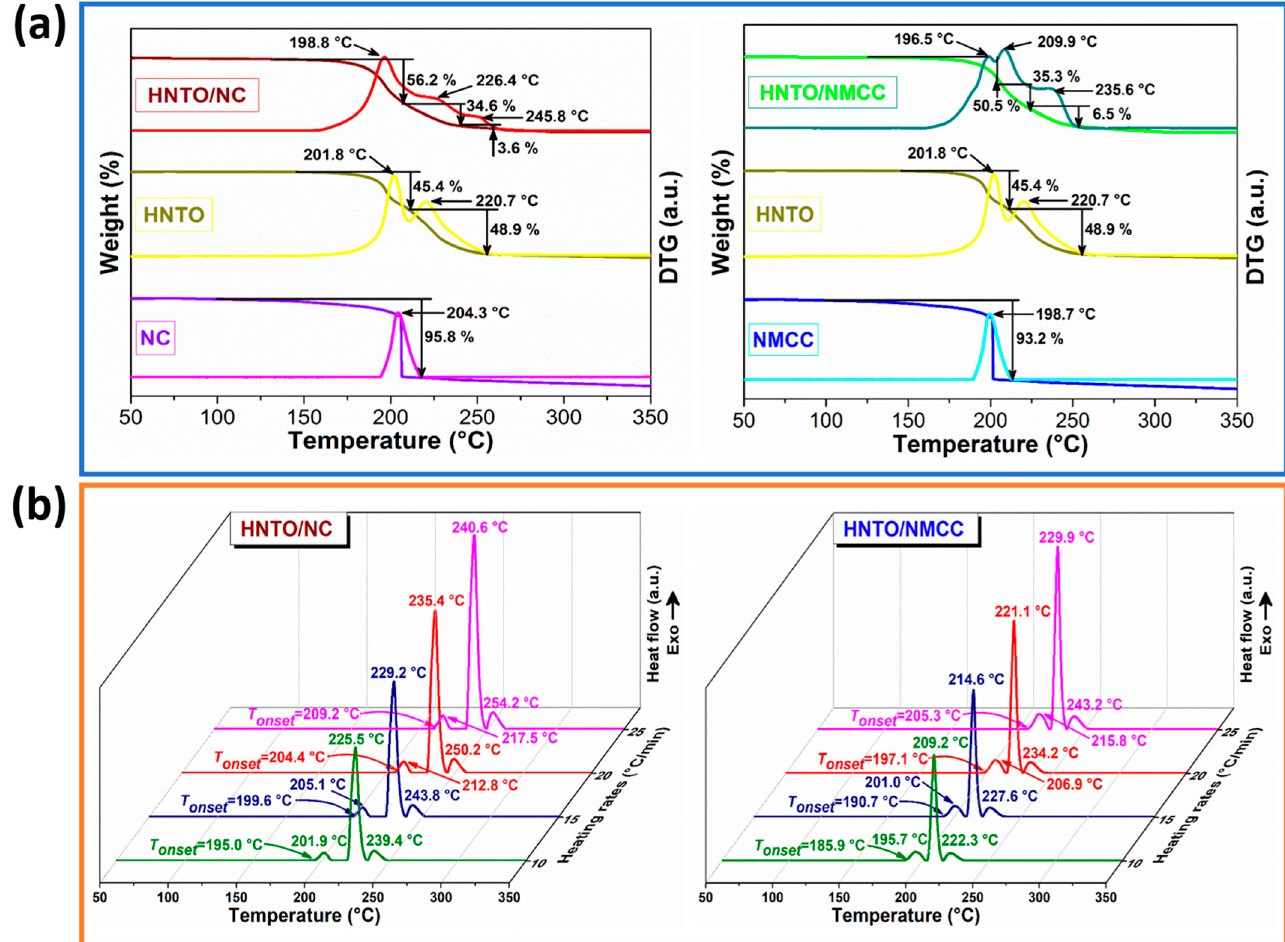
Figure 4. ( a ) TGA/DTG curves of the as-prepared energetic composites and their raw materials at β = 10 °C/min; ( b ) DSC thermograms of the as-prepared energetic composites at different heating rates.